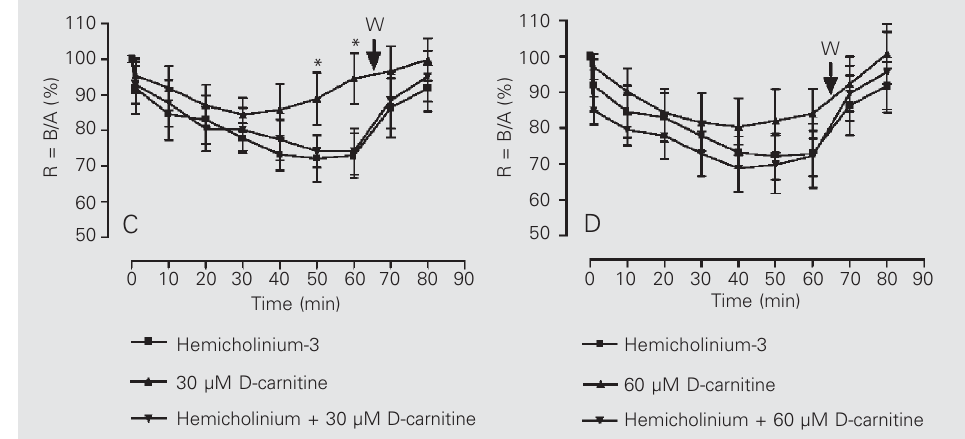
Figure 6. Percent reduction in R- values induced by choline and L- carnitine (LC), choline and DL- carnitine (DLC), and choline and D-carnitine (DC) in indirectly stimulated neuromuscular prep- arations. The R-ratio is reported on the ordinate as percent of that obtained in drug-free Krebs buffer, taken as 100% (t = 0). Choline was added 10 min be- fore the addition of LC, DLC or DC. LC, DLC and DC were added at t = 0. Each point represents the mean ± SEM of 4 experi- ments. *P < 0.05 compared to control (Student t